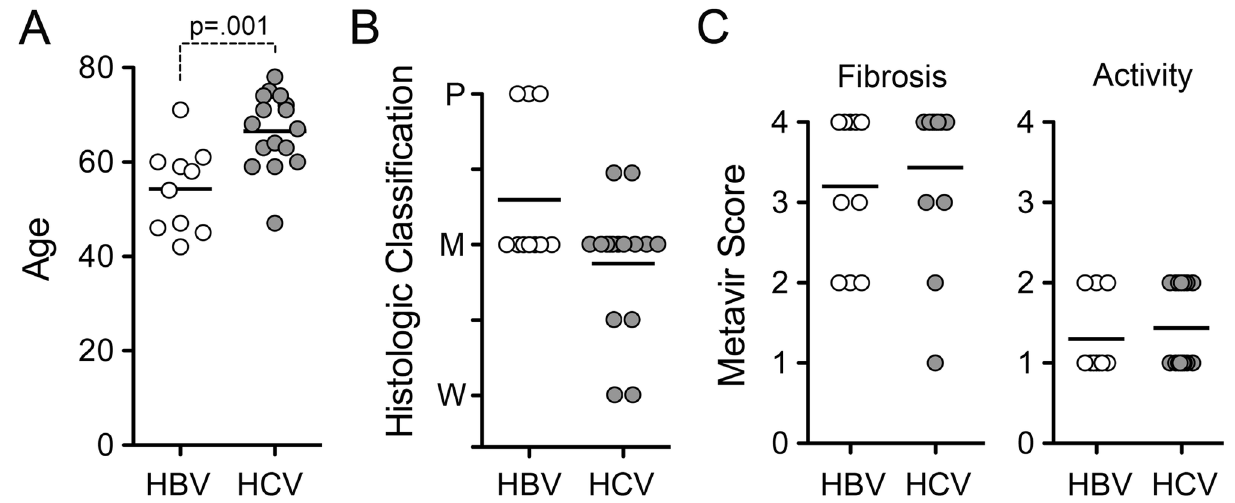
Figure 1. Age, histological classification of tumors, and scoring of non-tumor tissue for inflammation and fibrosis. ( A ) Age of subjects from whom HBV- and HCV-associated HCC and paired non-tumor samples were obtained. ( B ) Histological classification of tumors: W = well differentiated, M = moderately differentiated, P = poorly differentiated. ( C ) Individual scores for fibrosis and inflammatory activity in non-tumor tissue. Bars represent mean values. See also Table 1. doi: